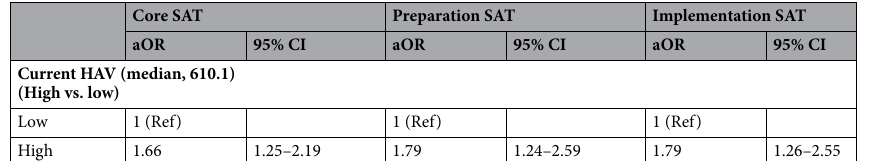
Core SAT Preparation SAT Implementation SAT aOR 95% CI aOR 95% CI aOR 95% CI Current HAV (median, 610.1) (High vs. low)